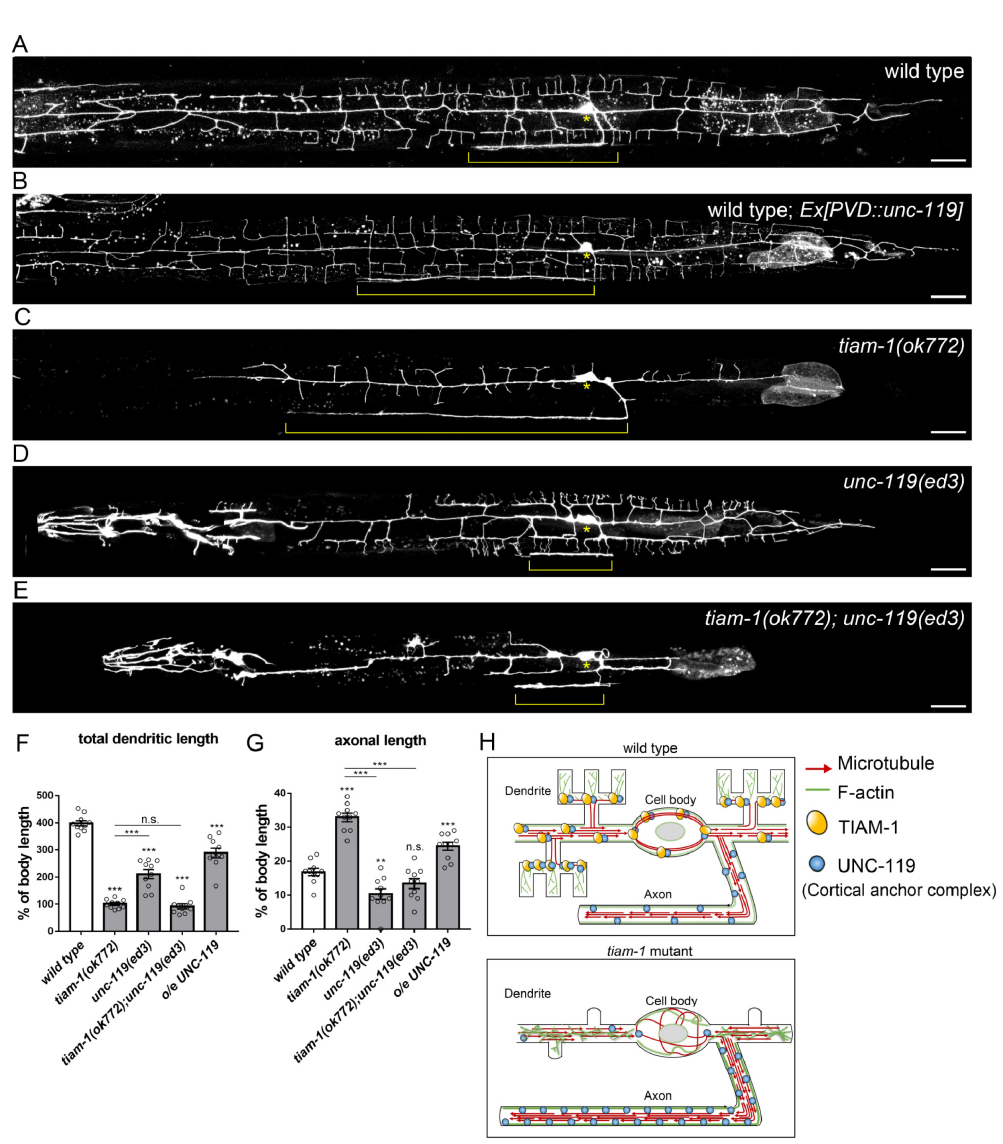
Fig 7. TIAM-1 regulates the development of axon through UNC-119. (A-E) PVD neuron expressing myr::mCherry under Pdes-2 promoter ( ntuIs1 ) of wild type (A), Ex[Pdes-2 :: unc-119] (B), tiam-1(ok772) (C) , unc-119(ed3) (D) , and tiam-1(ok772); unc-119(ed3) (E). Brackets indicate the axons and asterisks indicate the cell body. Scale bar, 20 μ m. (F and G) Quantification of the relative total dendritic length (F) and relative axonal length (G) in the indicated genotypes. One-way ANOVA, Error bar, SEM. n.s., not significant, � P < 0.05, �� P < 0.01, ��� P < 0.001, compared to wild type or tiam-1(ok772) . n = 10. (H) A proposed model of TIAM-1 in regulating microtubule organization. In wild type, TIAM-1 localizes UNC-119 to stabilize the organization of the cytoskeleton in somatodendritic regions. In tiam-1 mutant, MTs and actin filaments are disorganized in dendrites and the cell body, while mislocalized UNC-119 accumulates with MTs and actin filaments in the axon.